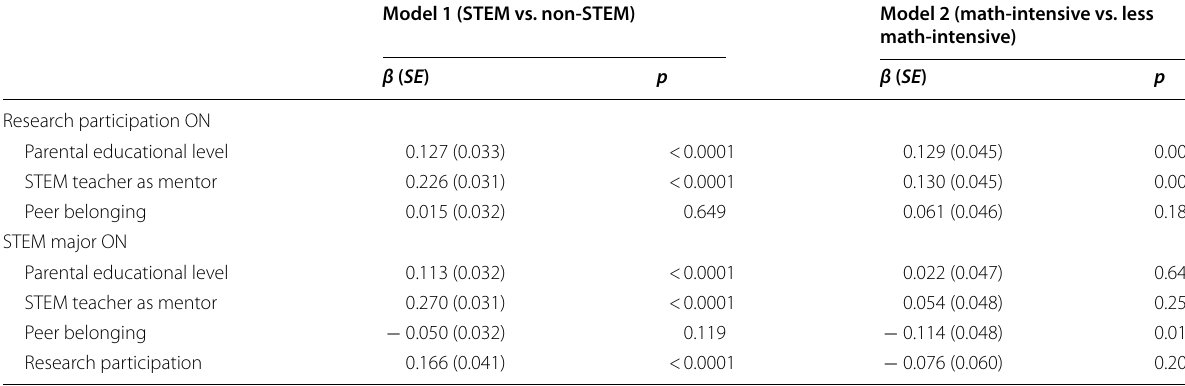
Table 2 Standardized path coefficients for the full path models Model 1 (STEM vs.